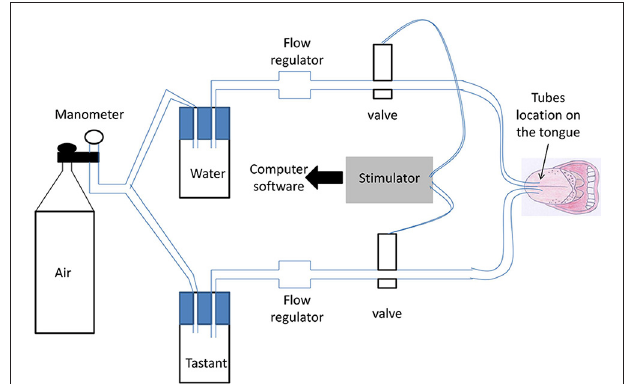
FIGURE 1 | Schematic view of the taste delivery system. Water and taste solutions were driven through the system by compressed air (controlled through a manometer). Two parallel silicone tubes were used; one for water and the other for the taste solution. Switching between water and the taste solutions was performed by two electromagnetic valves controlled by an electronic device. Each subject put the two parallel tubes on the middle of his/her tongue in his/her mouth. Solutions were delivered to the tongue through a hole at the end of each tube.